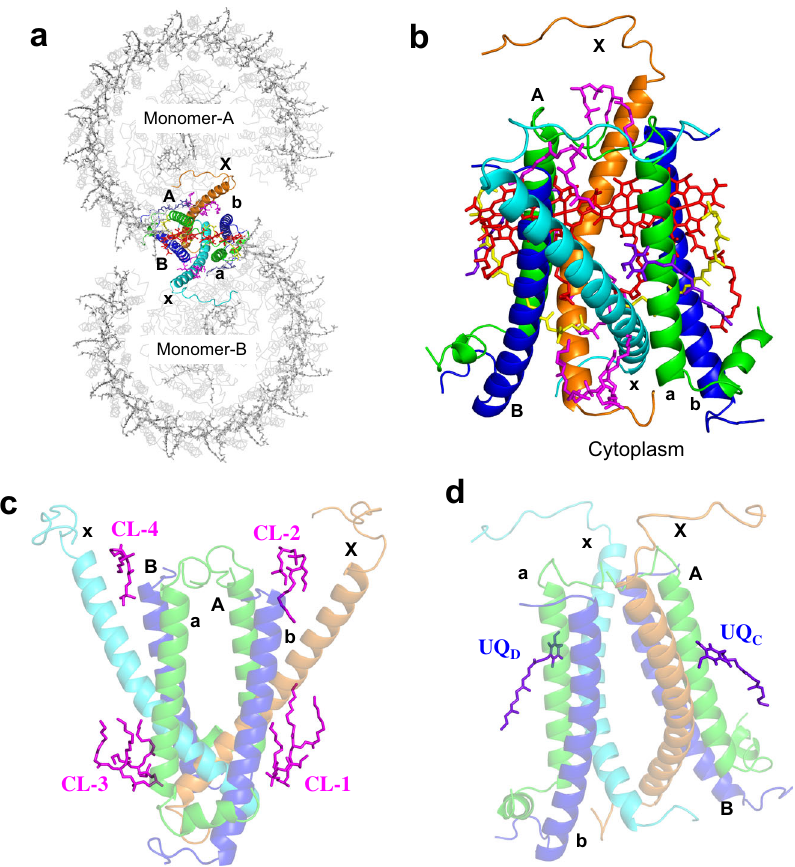
Fig. 3 Junction of the Rba. sphaeroides LH1 – RC dimer. a Top view from the periplasmic side of the membrane with the polypeptides and cofactors in the dimer junction shown in colors and by their chain ID: A, B, and X denote the α - (green), β - (blue), and PufX (orange) polypeptides in monomer A, respectively; a, b, and x denote the α - (green), β - (blue), and PufX (cyan) polypeptides in monomer B, respectively. BChl a and spheroidenes are shown by red and yellow sticks, respectively. Cardiolipin (CL) and UQ molecules are shown by magenta and purple sticks, respectively. b Side view of the expanded dimer junction with the same color scheme as in ( a ). c Four CL molecules (magenta sticks) in the dimer junction. d Two UQ molecules (purple sticks) in the dimer